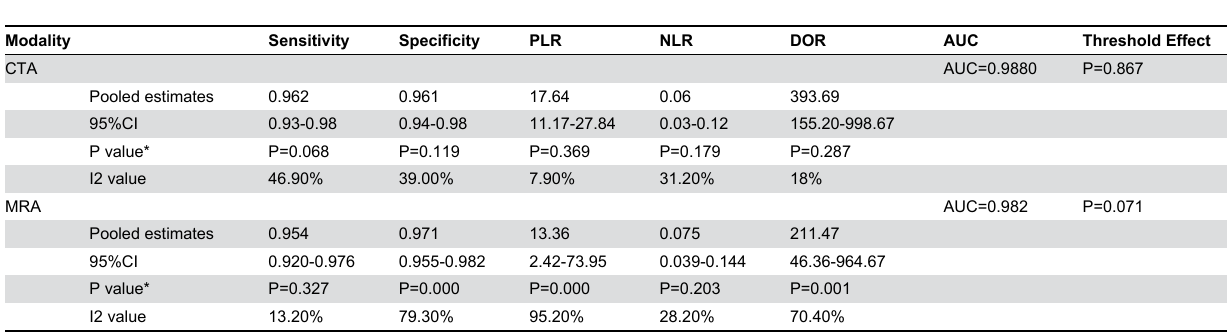
Table 2. Weighted summary of sensitivity, specificity, and OR for each